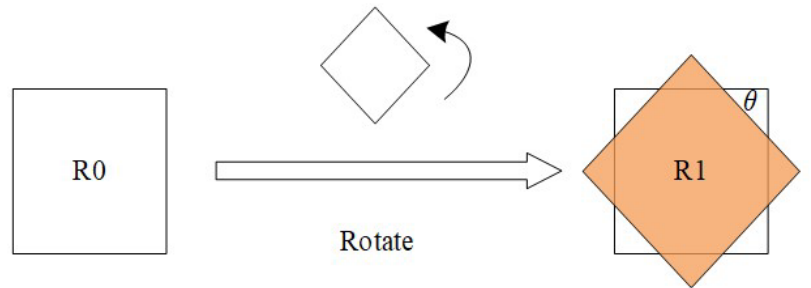
Figure 14. The prediction object and ground truth.